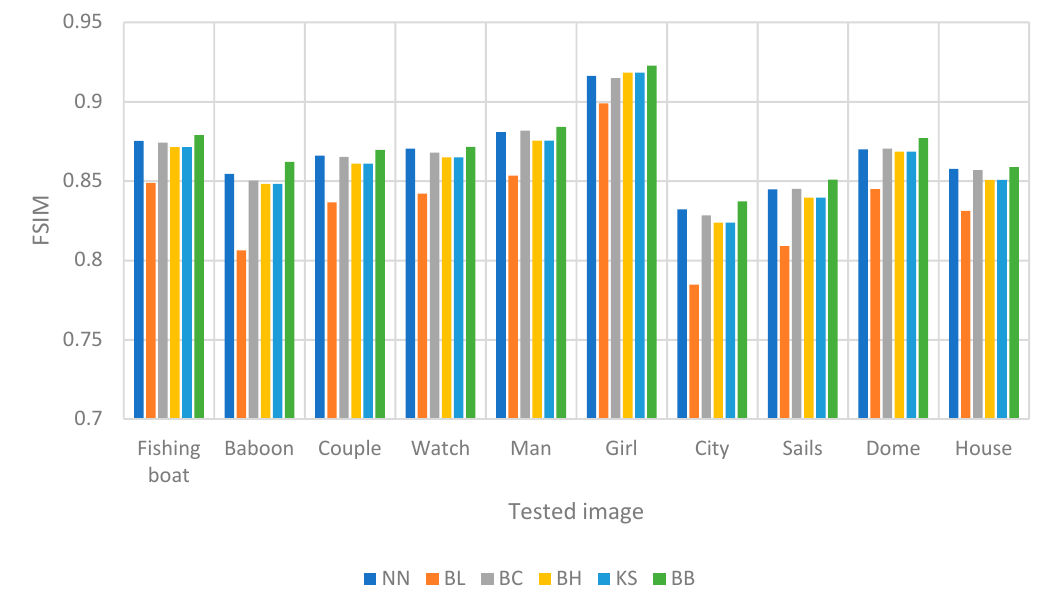
Figure 10. A comparison of schemes toward RMSE for image upscaling with a factor of four. Mathematics 2019 , 7 , x FOR PEER REVIEW